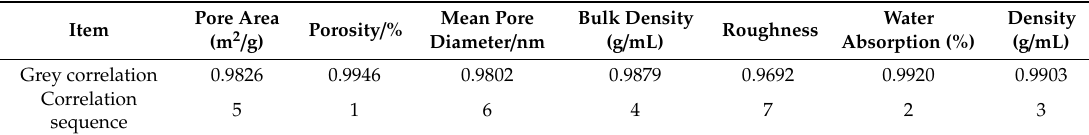
Table 12. Calculation results of grey entropy correlation degree.